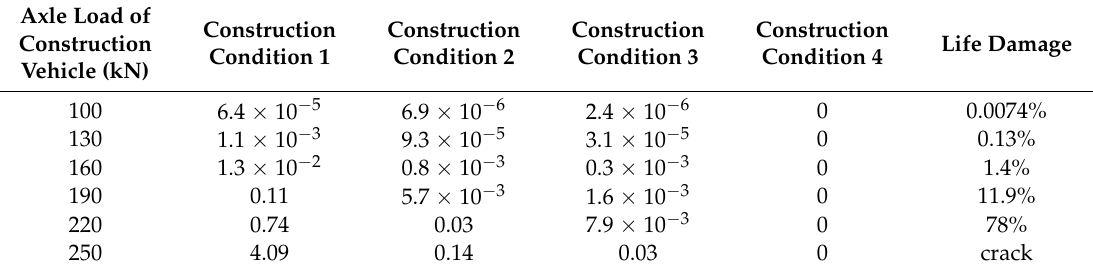
Figure 14. Damage values of subbase under different working conditions. Table 7. Life loss of pavement under different construction loads.